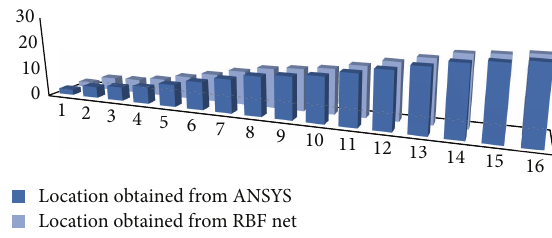
Figure 17: Comparison of result of crack location between ANSYS and RBF